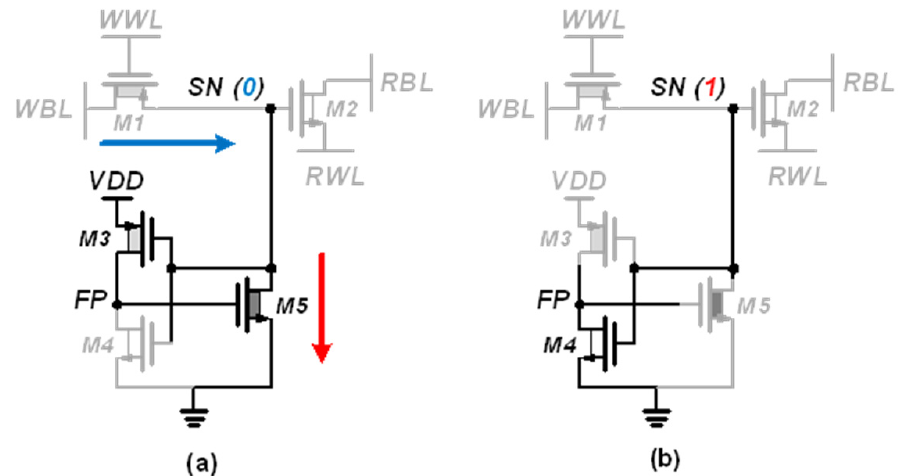
Figure 7. Leakage compensation of PS-GC when storing data ( a ) “0” and ( b ) “1”.